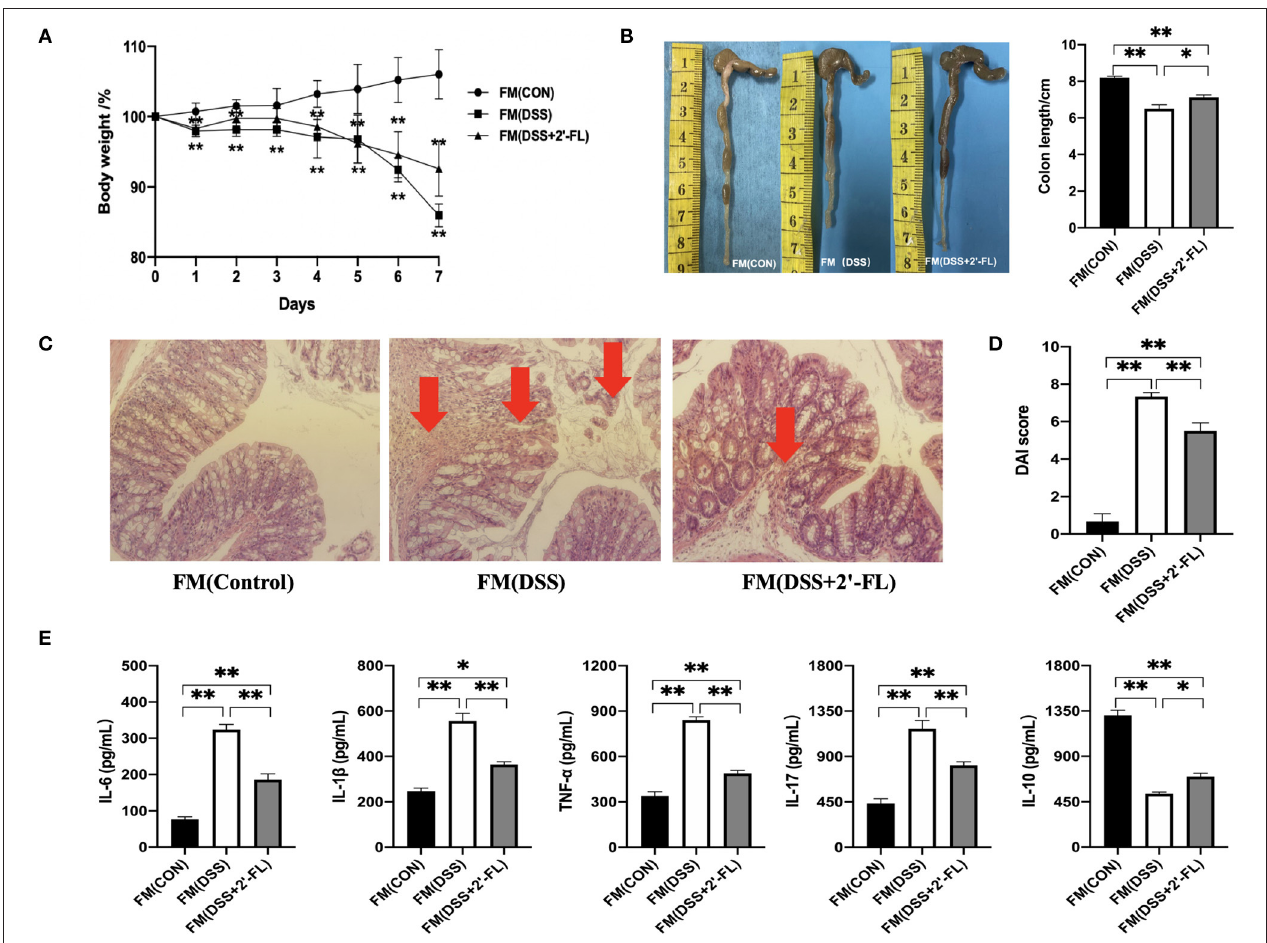
FIGURE 4 | Gut microbiota is involved in the process of 2 ′ -FL mitigation of colon inflammation. (A) Changes in body weight of mice after receiving 5% DSS water; (B) The representative images (Left) and statistical analysis (Right) of colon length; (C) Representative images of colon by H & E staining (100 × ); (D) DAI indices. (E) Cytokine levels in serum of FMT C57BL/6J mice detected by ELISA. Significance was determined using one-way ANOVA analysis and expressed as mean ± SEM. * p < 0.05; ** p <